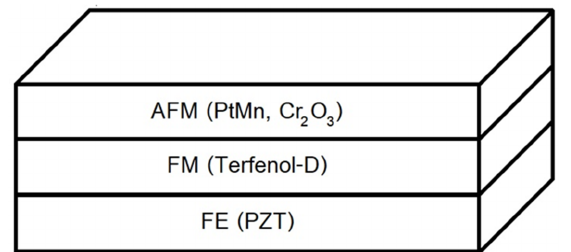
Figure 1. The tri–layer sensor structure consists of FE, FM, and AFM.